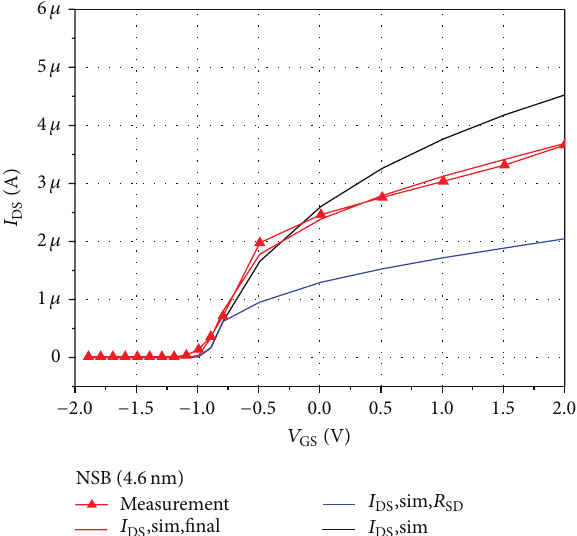
Figure 8: Simulated 𝐼 DS - 𝑉 GS data including the resistance in series to the drain terminal compared to the measured one for NBS device. An exponent value of 0.93 in (9) gave the best fit to measurement. 𝑉 DS is fixed to